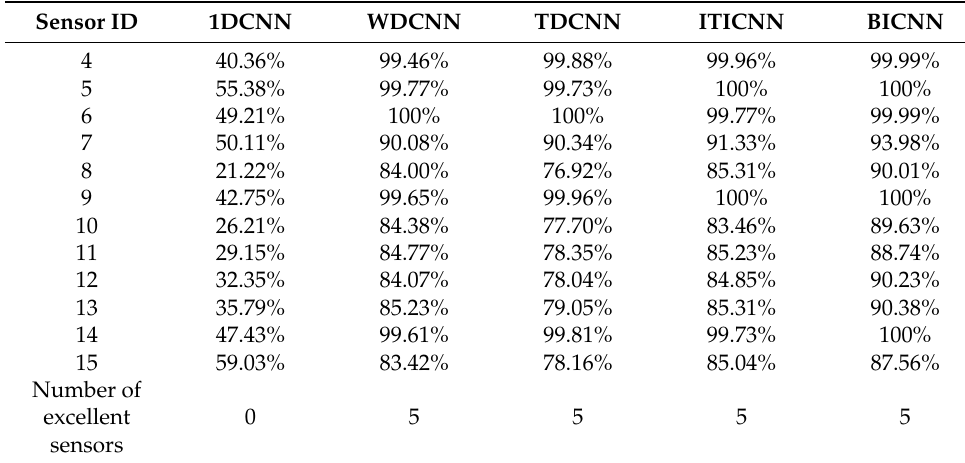
Table 4. Experimental results of optimizing training